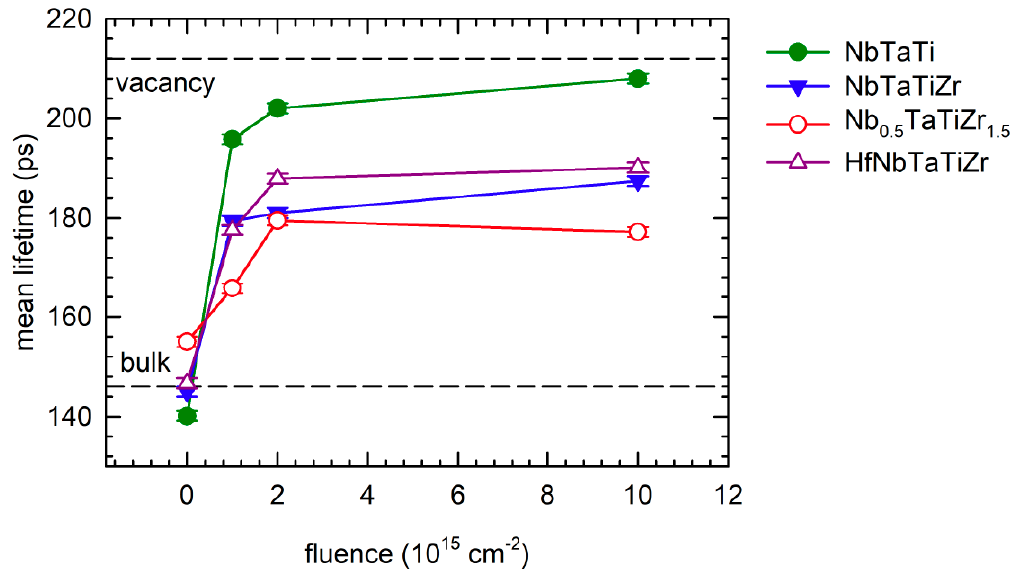
Figure 8. The development of the mean positron lifetime of NbTaTi, NbTaTiZr, Nb 0.5 TaTiZr 1.5 , and HfNbTaTiZr alloy with the irradiation fluence.